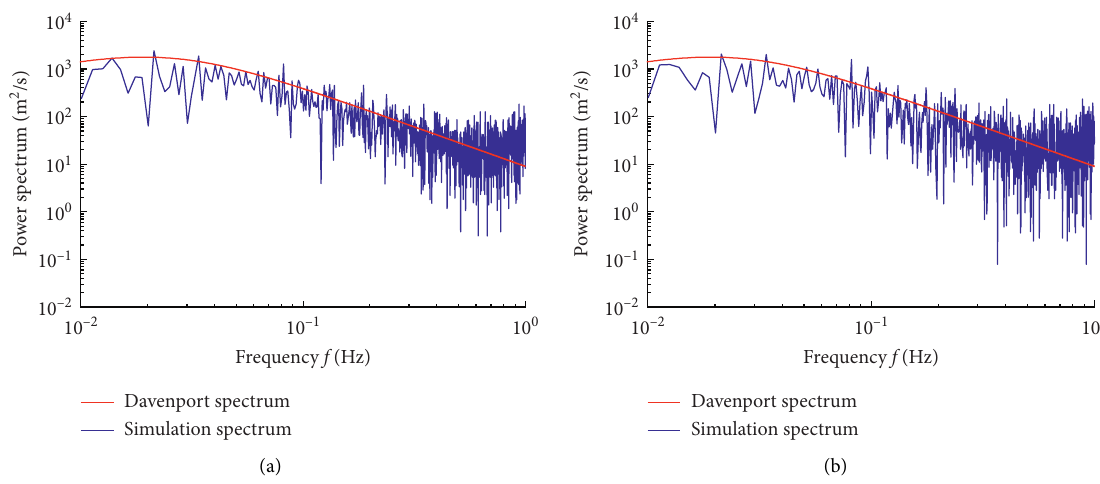
Figure 7: Fluctuating wind power calculation power spectrum contrasting with target power spectrum. (a) Node 4. (b) Node